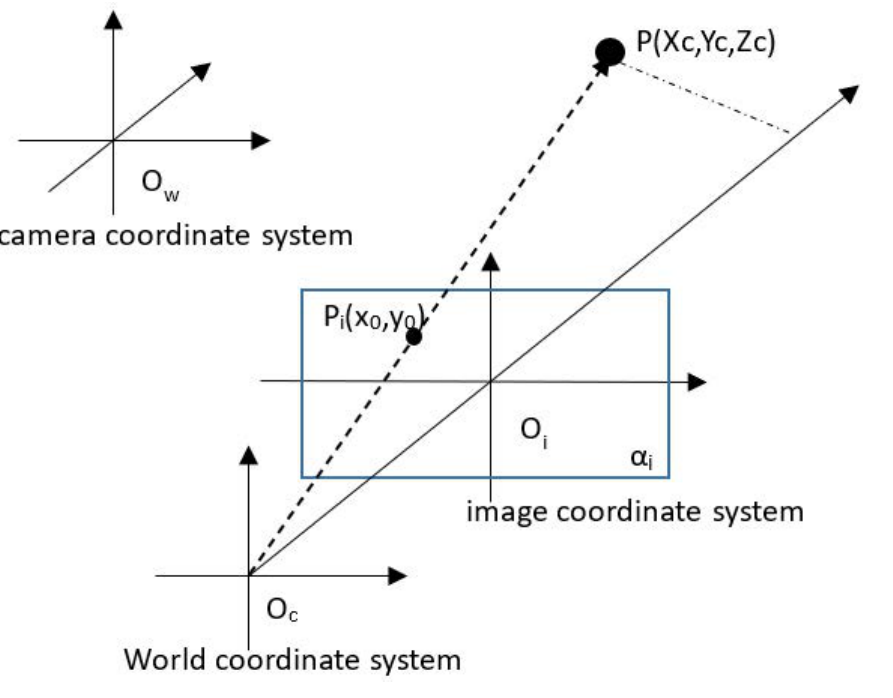
Figure 1. Pinhole imaging